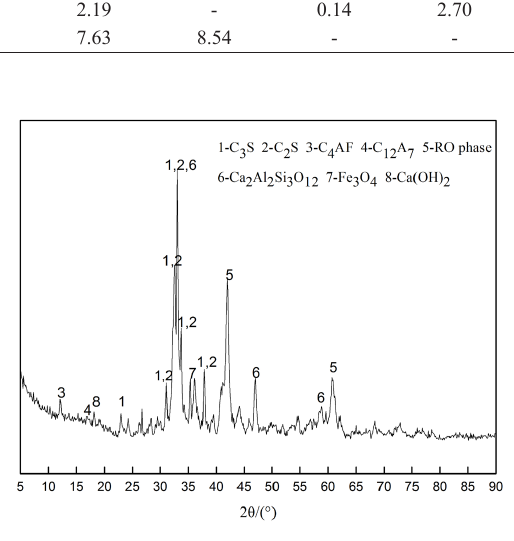
Fig. 1. XRD pattern of Xin Yu hot stuffy steel slag.